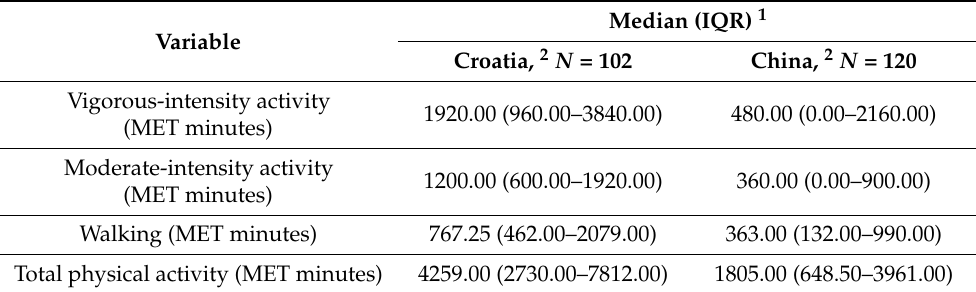
Table 4. Physical activity of Croatian and Chinese university students during the COVID-19 lock-